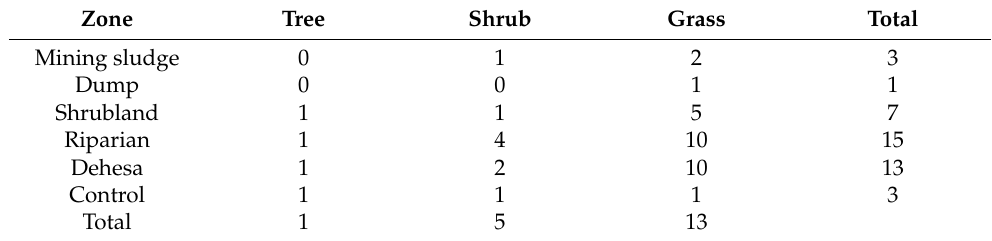
Table 4. Number of plant species found around the sampling points by habit and by zone. Zone Tree